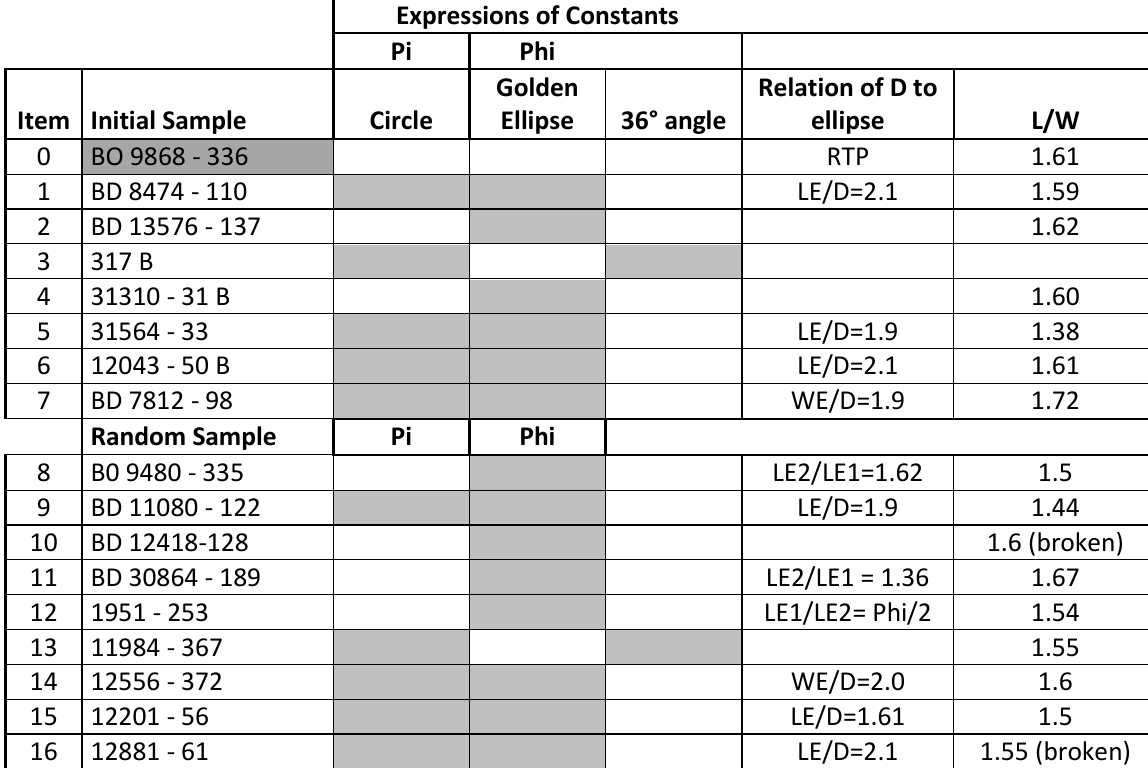
Table 1. Summary of the mathematical expressions and computed relationships in samples of the Boxgrove